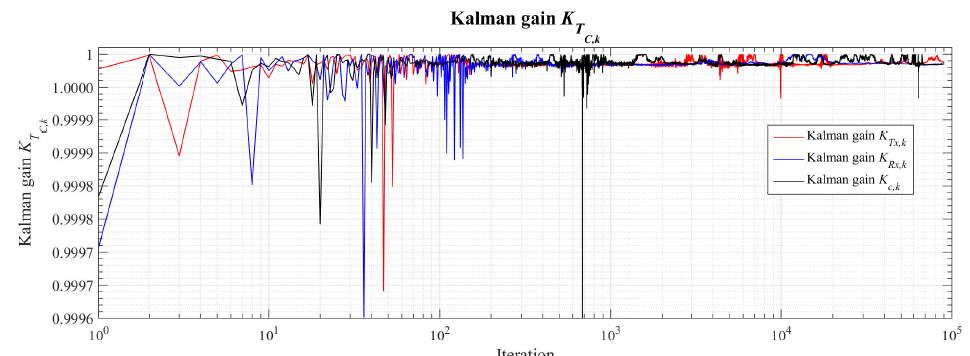
for the reconstruction of communication times T C , k (using C , k